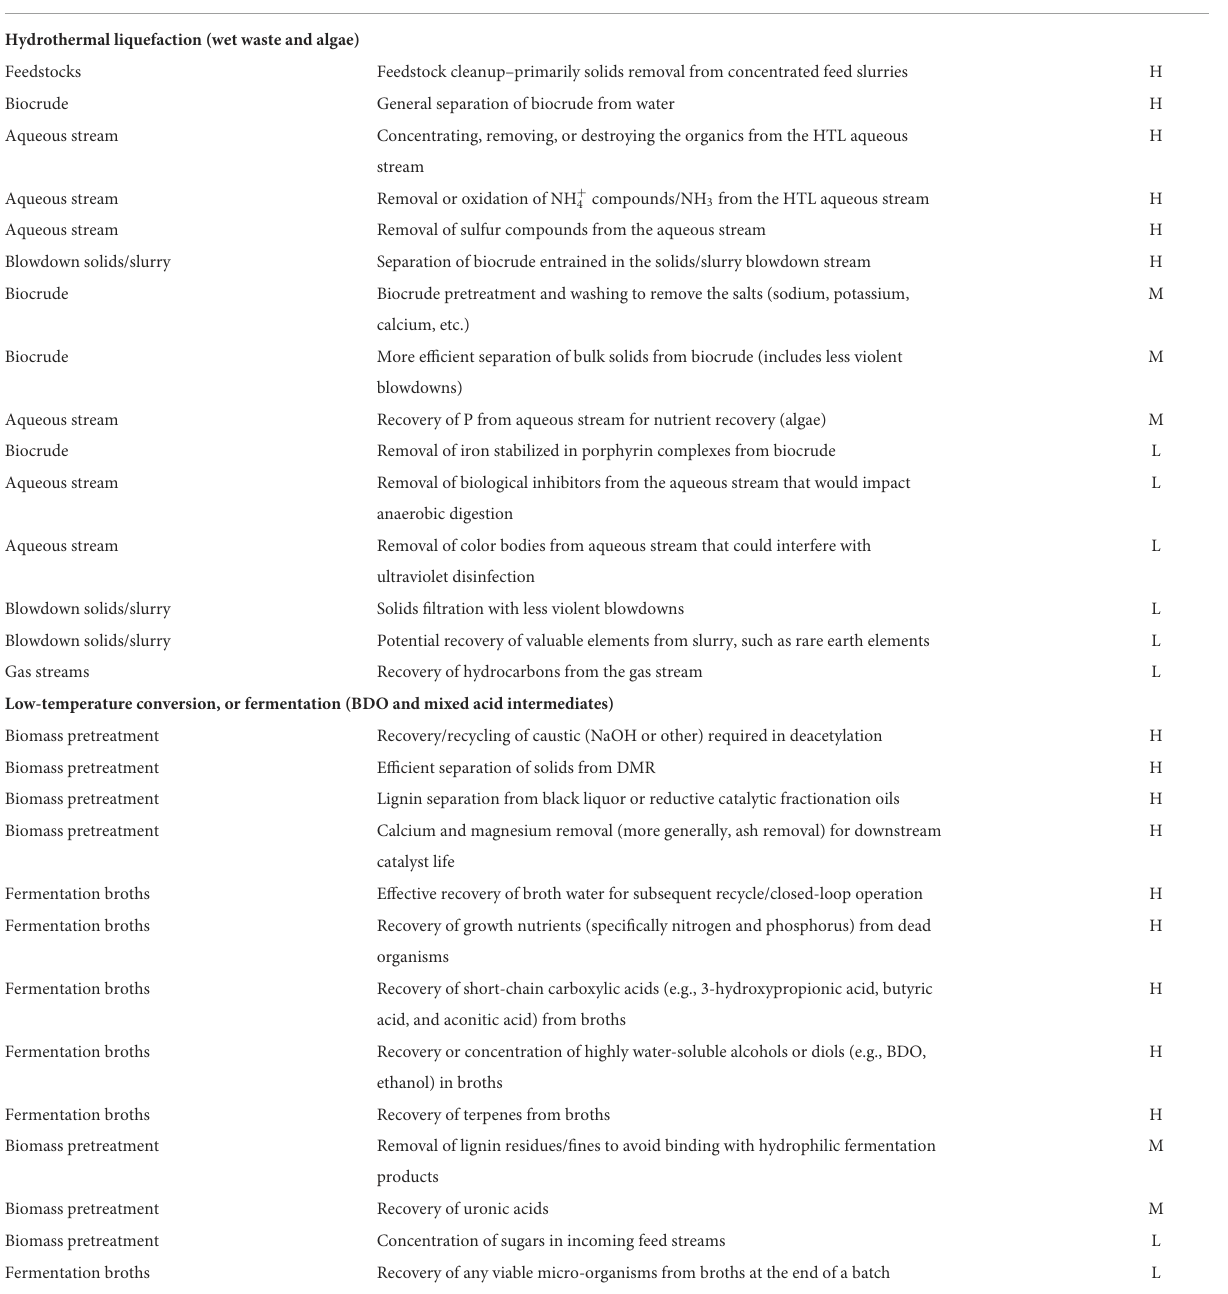
TABLE 1 Identified challenge streams for two sets of BETO conversion